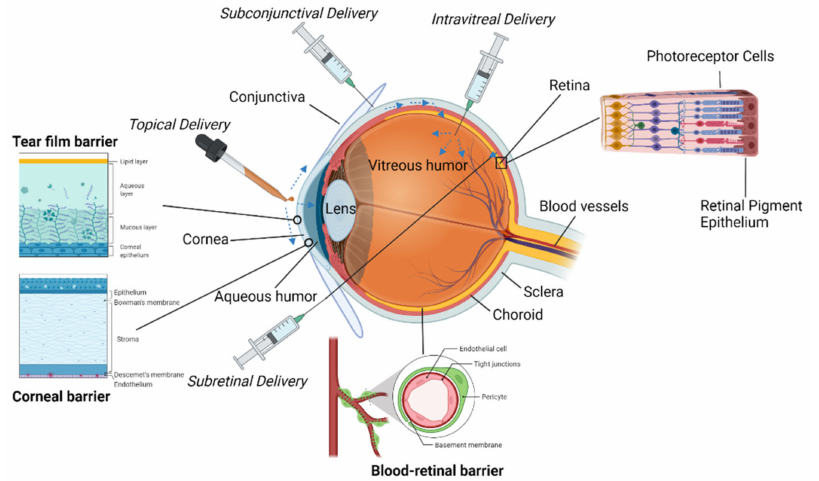
Figure 1. The ocular anatomy, key barriers, and four primary routes of delivery, including topical, intravitreal, subretinal, and subconjunctival. Figure created with BioRender.com (29 December